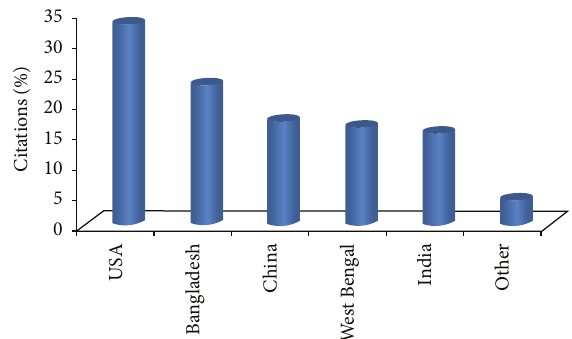
Figure 1: Regions with high levels of arsenic contamination in